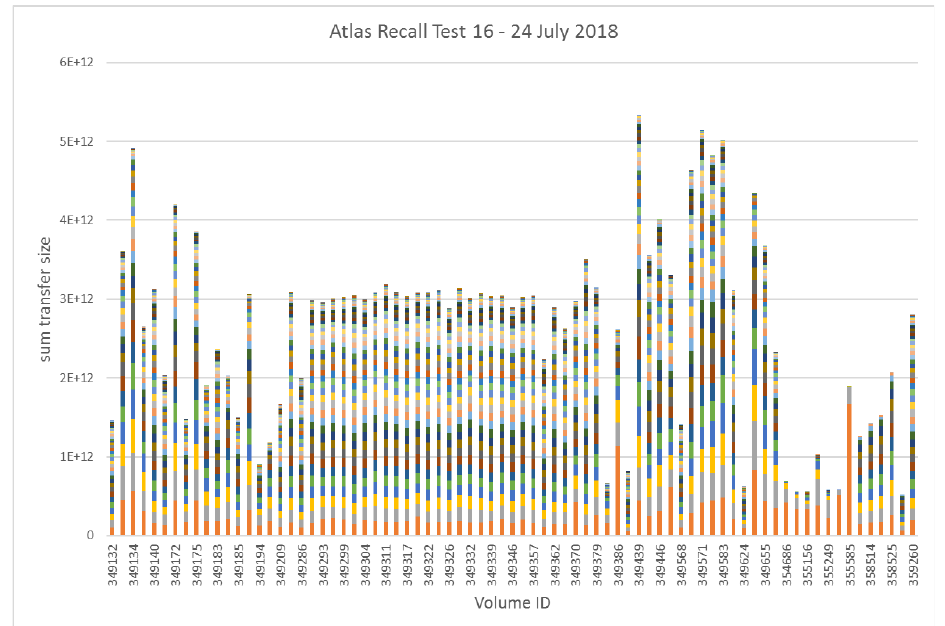
Figure 3: total required data transfer per tape catridge to restore 25 ATLAS datasets